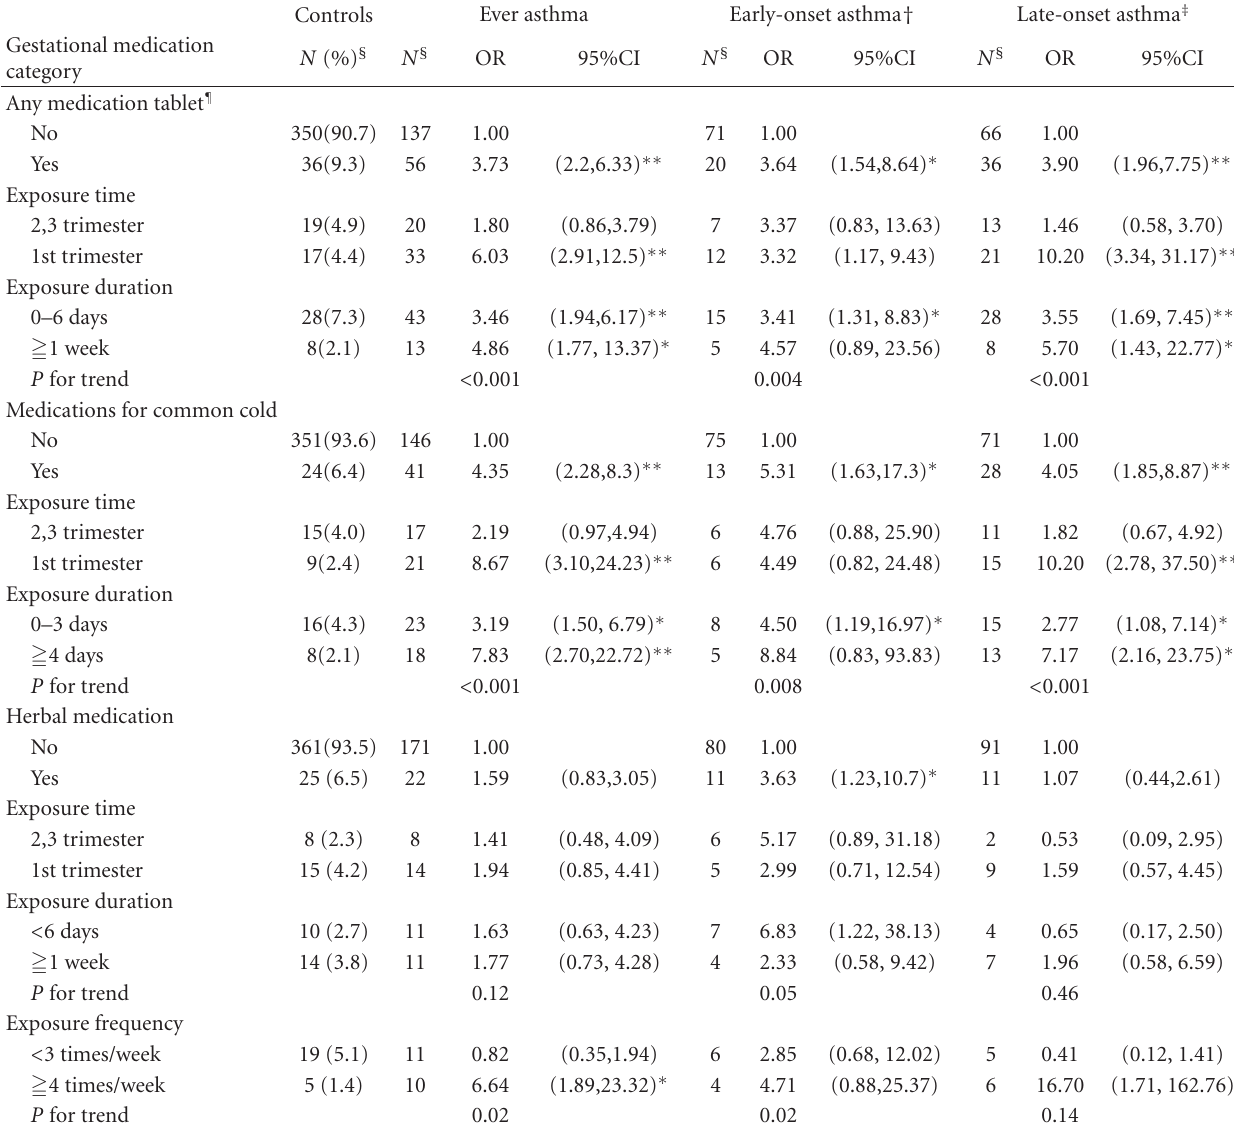
Table 2: Risks for childhood asthma in relation to gestational medication